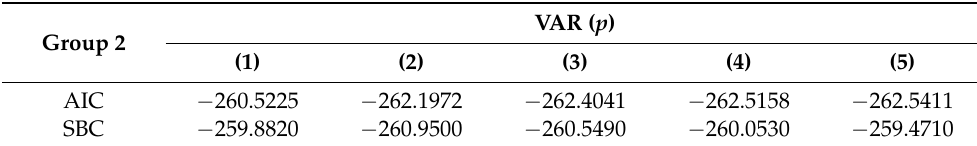
Table 2. Fitting results for p of the VAR model for Group 2.